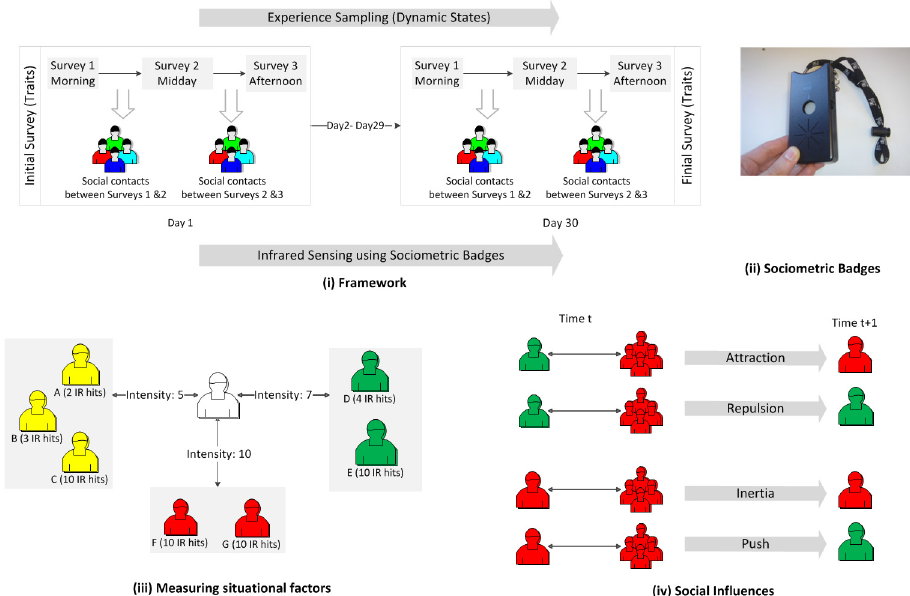
Fig 1. (i) Framework of the Study: First, participants filled a survey capturing personality and affect (stable) traits. Then they filled 3 daily surveys for 30 work days to measure personality and affect (dynamic) states. (ii) Sociometric Badge: Each participant ’ s social network between any two consecutive surveys was constructed from infrared sensor data from sociometric badges worn around the neck [49]. (iii) Measuring Situational Factors: An example of how the situational factors (intensity of contacts) is calculated. The ego ’ s infrared sensor (in the middle) detected 7 alters between two consecutive surveys. Two of the alters were in the high level (green) with 14 infrared hits, leading to intensity of contact 14/2 = 7. Similarly, the intensity of contact with three alters in the neutral level (yellow) is 15/3 = 5 and that for alters in the low level (red) is 20/ 2 = 10. (iv) Social Influences: Four possible social influences exemplified. Attraction: an ego in the high level interacts with others in the low level, then moves to the low level to adapt to his peers. Repulsion: a participant in the high level interacts with others in the low level, and consequently remains in the high level in complement to his peers. Inertia: a participant in the low level interacts with others in the same level, who prevent him from moving to a different level, maintaining his adaptation to their level. Push: a participant in the low level interacts with others in the same level, as a result pushing him away to a different, complementary level.